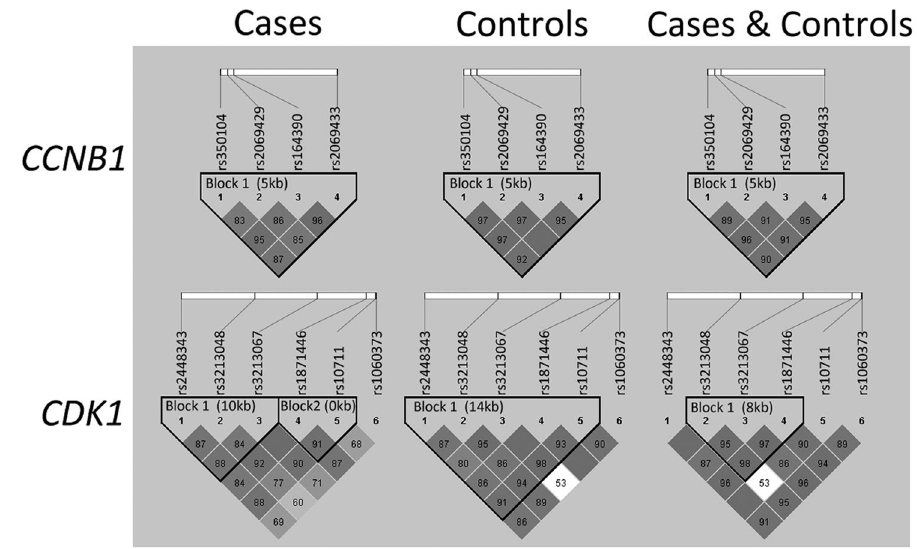
Figure 1. LD maps of the analyzed ten SNPs in controls and BC cases. The values shown in each diamond are the D’*100 (10 means 0.10, 1 means 0.01). Dark grey diamonds without a number indicate that the value of D’ is 1. The dark grey-to-white gradient reflects higher to lower LD values.